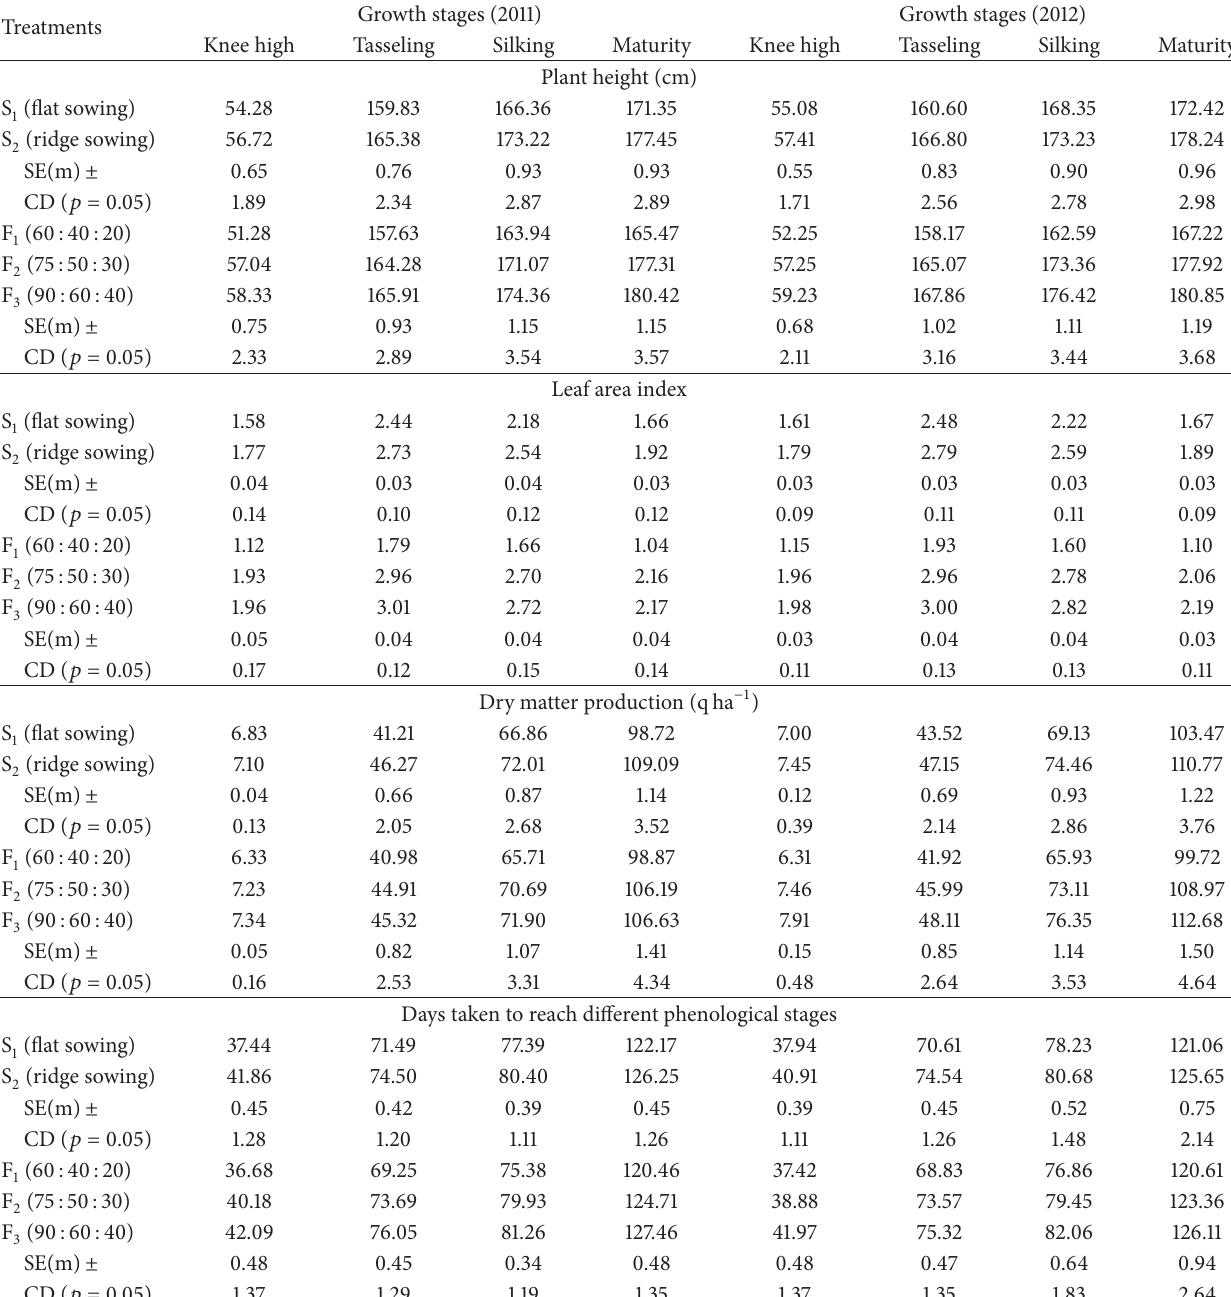
Table 1: Growth characters of maize at different growth stages as affected by sowing methods and NPK